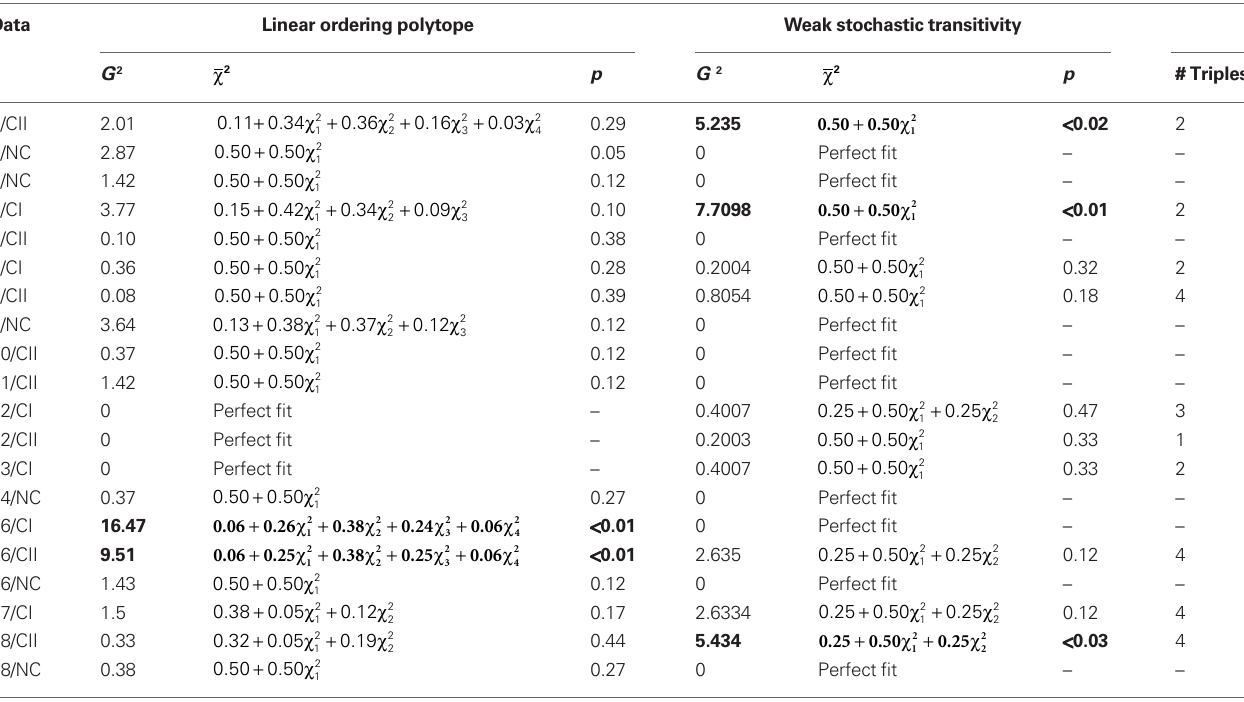
Table 2 | goodness-of-fit of the linear ordering polytope and weak stochastic transitivity.